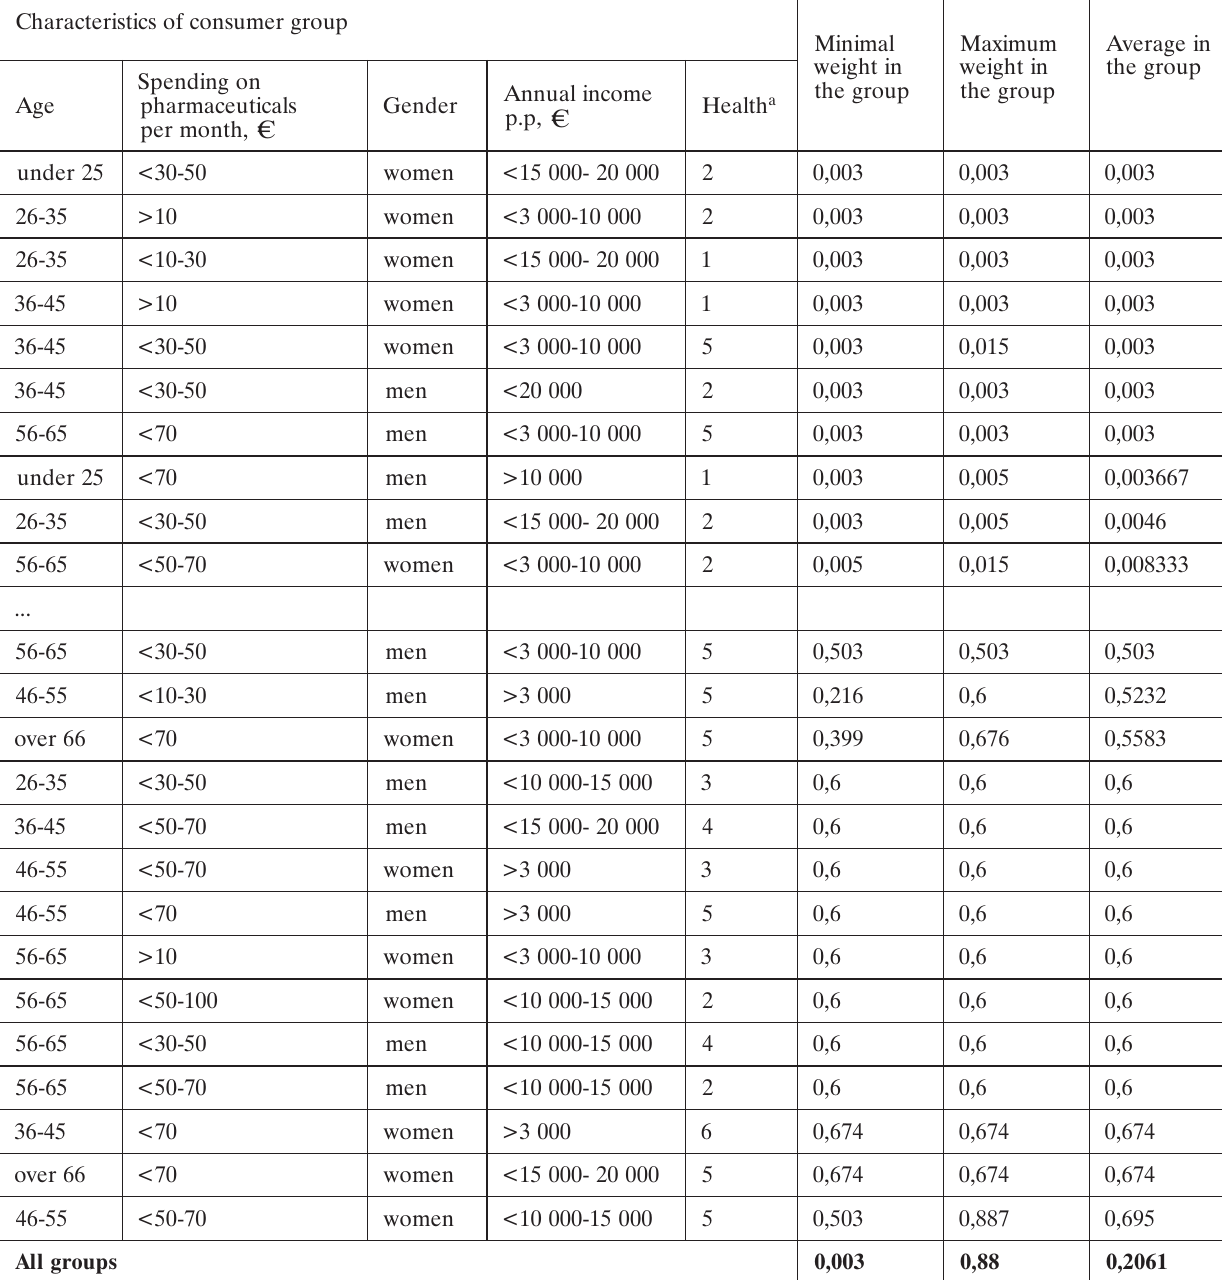
Table 8. Pharmaceutical consumer vulnerability according to consumer